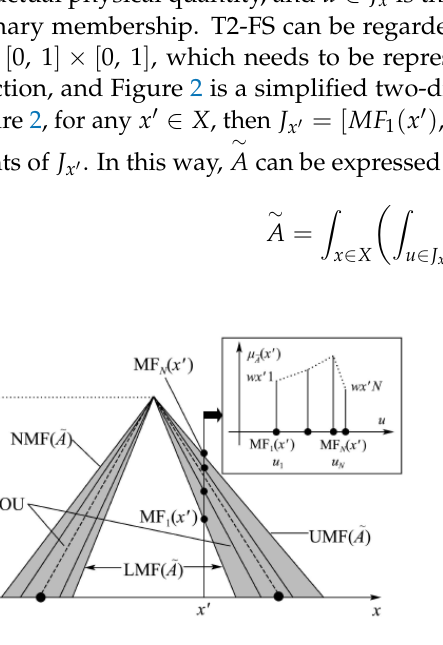
Figure 2. Type-2 fuzzy set in a two-dimensional plane.